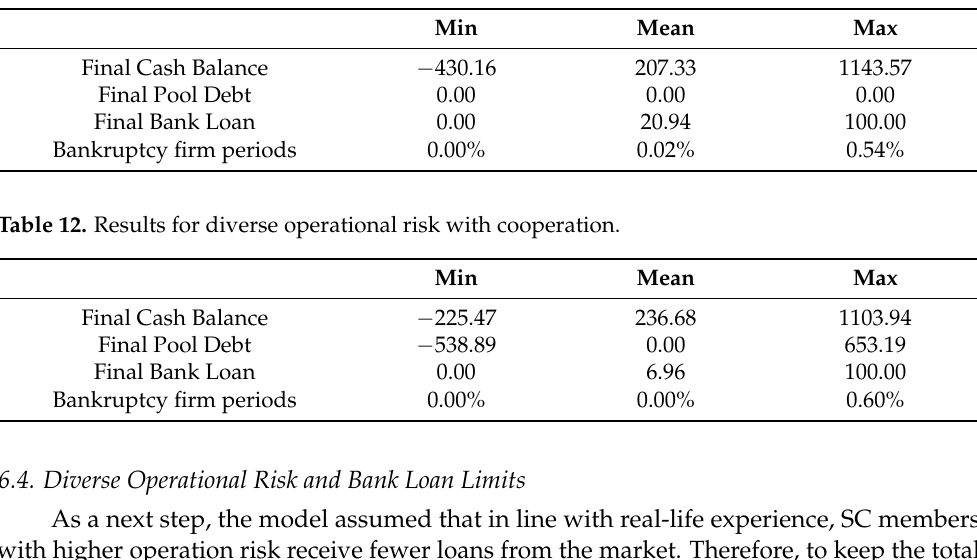
Table 11. Results for diverse operational risk without cooperation.